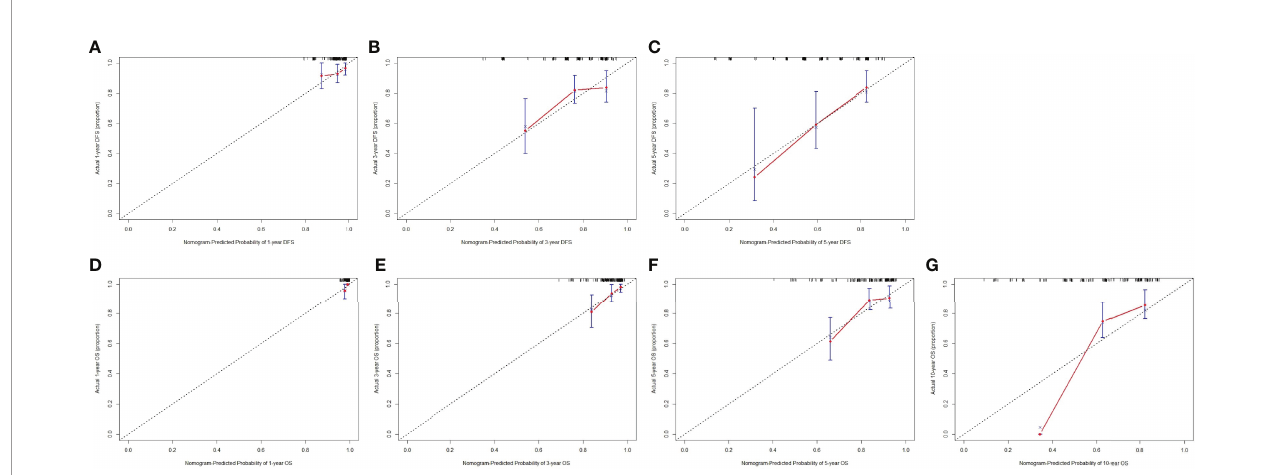
FIGURE 3 | The calibration curves for predicting the 1-year, 3-year, 5-year DFS rate and 1-year, 3-year, 5-year, 10-year OS rates in patients with breast cancer who underwent NACT. The X-axis presents the nomogram-predicted probability of disease free survival (DFS) and overall survival (OS); the Y-axis shows the actual DFS and OS. (A) The calibration curves for predicting the 1-year DFS rate in patients with breast cancer; (B) The calibration curves for predicting the 3-year DFS rate in patients with breast cancer; (C) The calibration curves for predicting the 5-year DFS rate in patients with breast cancer; (D) The calibration curves for predicting the 1-year OS rate in patients with breast cancer; (E) The calibration curves for predicting the 3-year OS rate in patients with breast cancer; (F) The calibration curves for predicting the 5-year OS rate in patients with breast cancer; (G) The calibration curves for predicting the 10-year OS rate in patients with breast cancer.